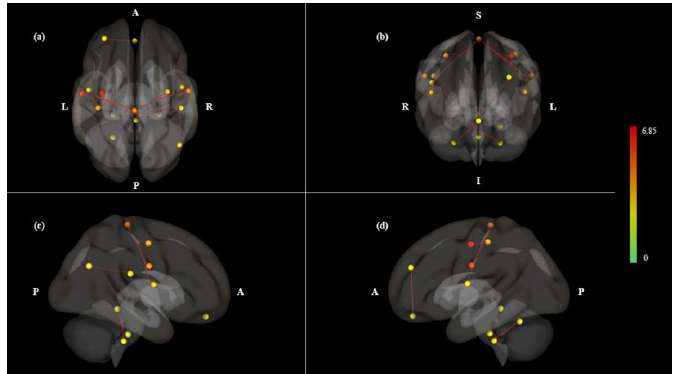
Figure 3. ROI-to-ROI 3D rendering maps of all selected ROI seeds in Mouth < Nose contrast, which was the same result as Figure 1b. 3D maps presented ( a ) dorsal, ( b ) anterior, ( c ) right and ( d ) left views. The maps are obtained at a ROI-to-ROI connections height threshold (FDR) of P < 0.05, seed ROI height threshold (uncorrected) of P < 0.05, with one-sided positive seed level correction and permutation tests. The color bar indicates the statistical T value. Abbreviations: ROI, region of interest; FDR, false discovery rate.